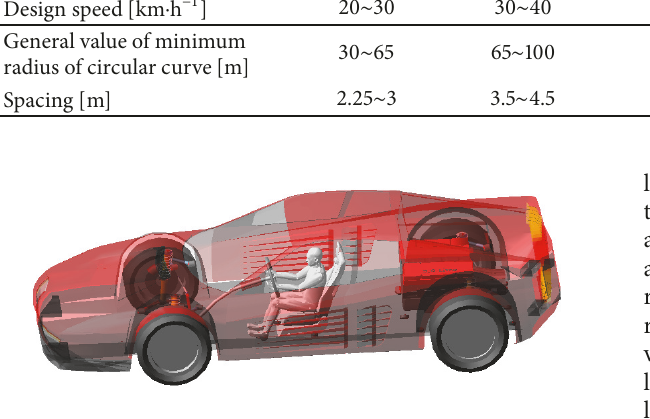
Figure 2: The man-chair-vehicle integration model (Take Santana 2000 as an